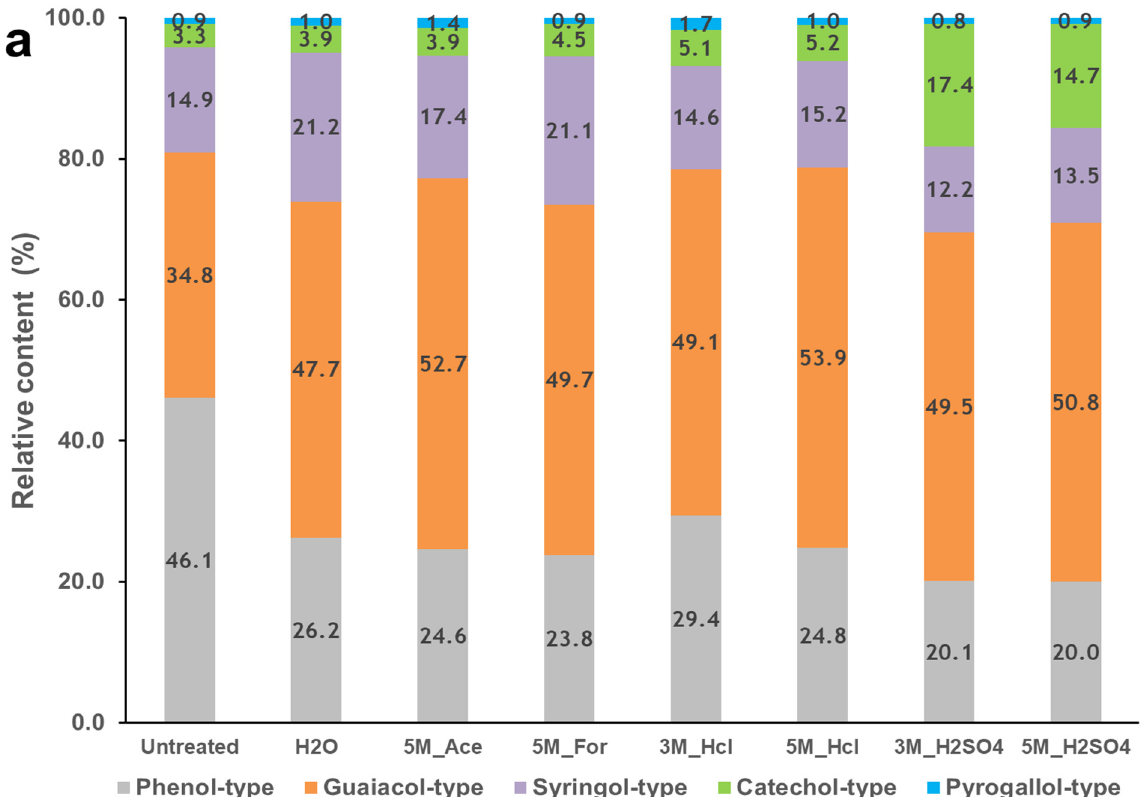
Figure 8a–c and Tables S4–S6 show a grouping of the phenols into phenol-type, guai- acol-type, syringol-type, catechol-type and pyrogallol-type compounds, respectively. Phenol-type compounds include phenol, 2-methylphenol and 4-methylphenol, while